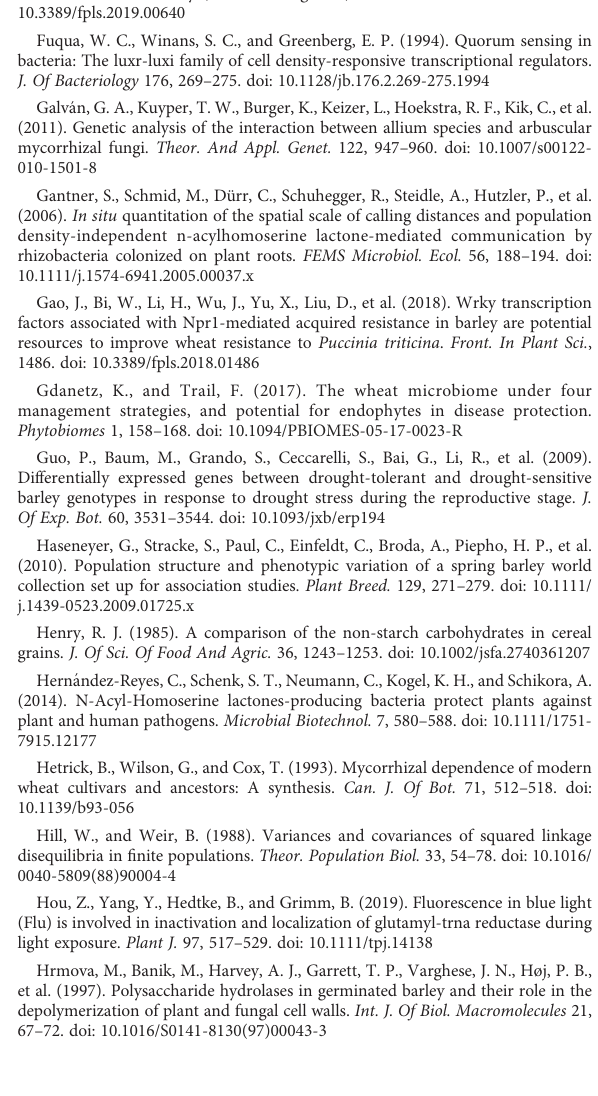
barley accessions and landraces of worldwide origin and including a test set of six common barley lines. * The UN 3-letter country code was used. SUPPLEMENTARY FIGURE 2 QQ-Plot for model selection of a compressed mixed linear model (cMLM, A ) with kinship as cofactor, cMLM with q-matrix and kinship as cofactors (B) and a generalized linear model (GLM, C ). SUPPLEMENTARY FIGURE 3 Manhattan plots for relative infection of P. hordei for 200 accessions primed with E. meliloti strain attM (red) or expR+ch (blue) against physical positions (Mb) of the marker trait associations on the seven barley